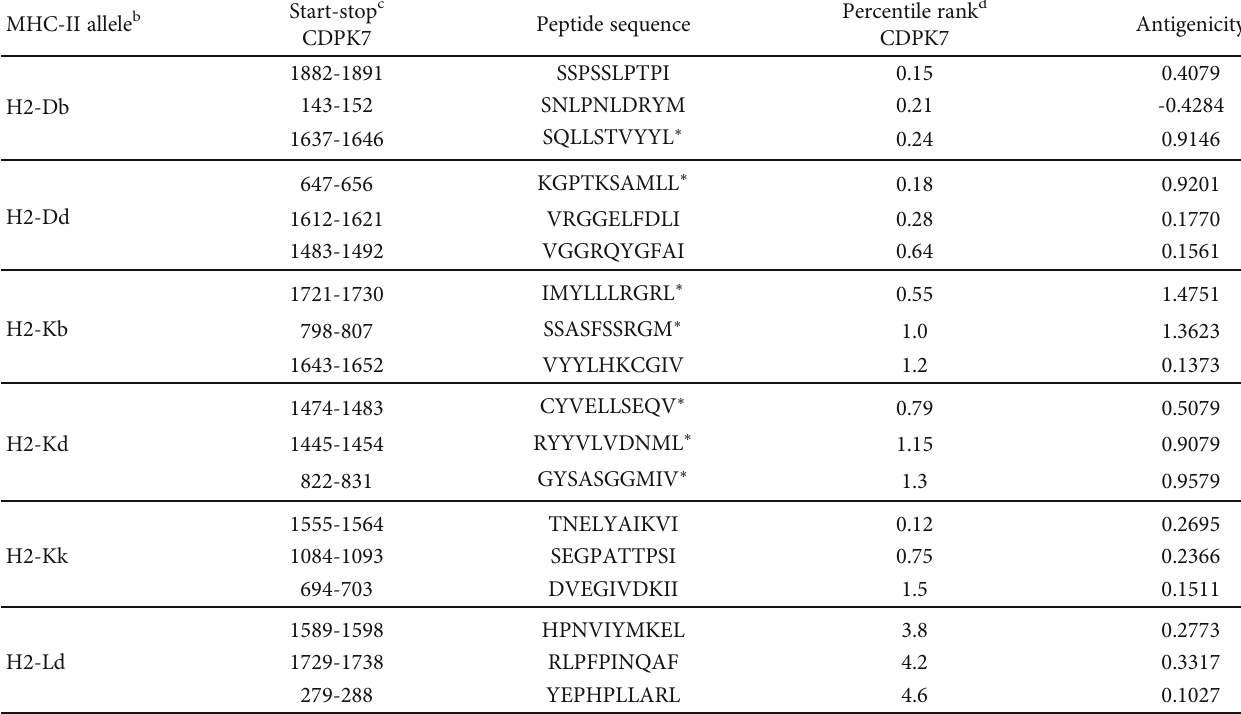
Table 5: IC values for CDPK7 binding to MHC class I molecules obtained using the IEDB a . 50 MHC-II allele b